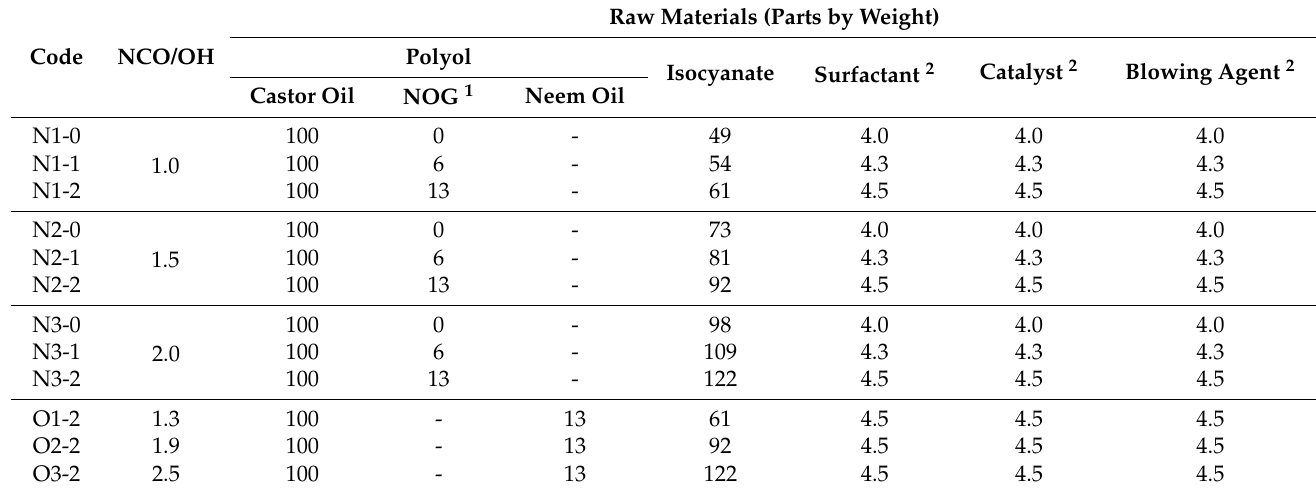
Table 1. The weight of the raw materials set as to prepare bio-based PU